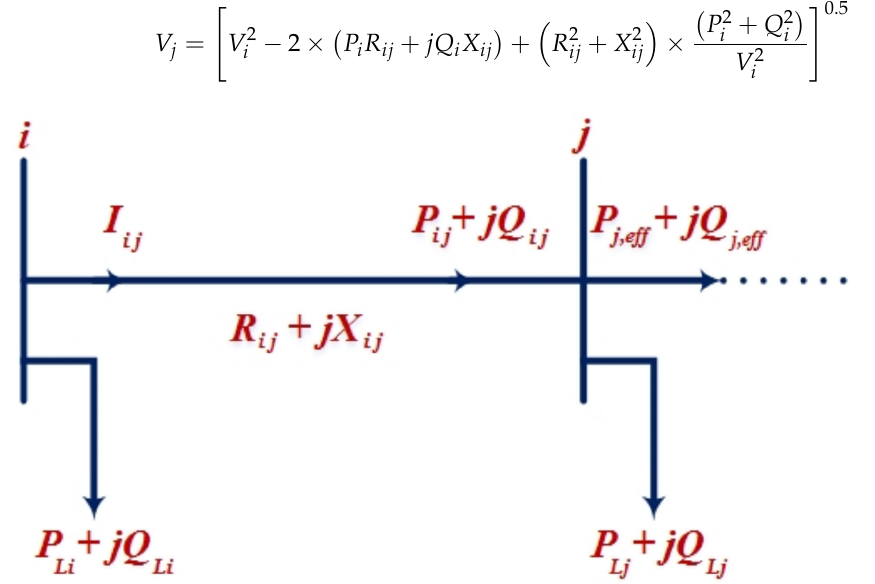
Figure 2. A radial distribution